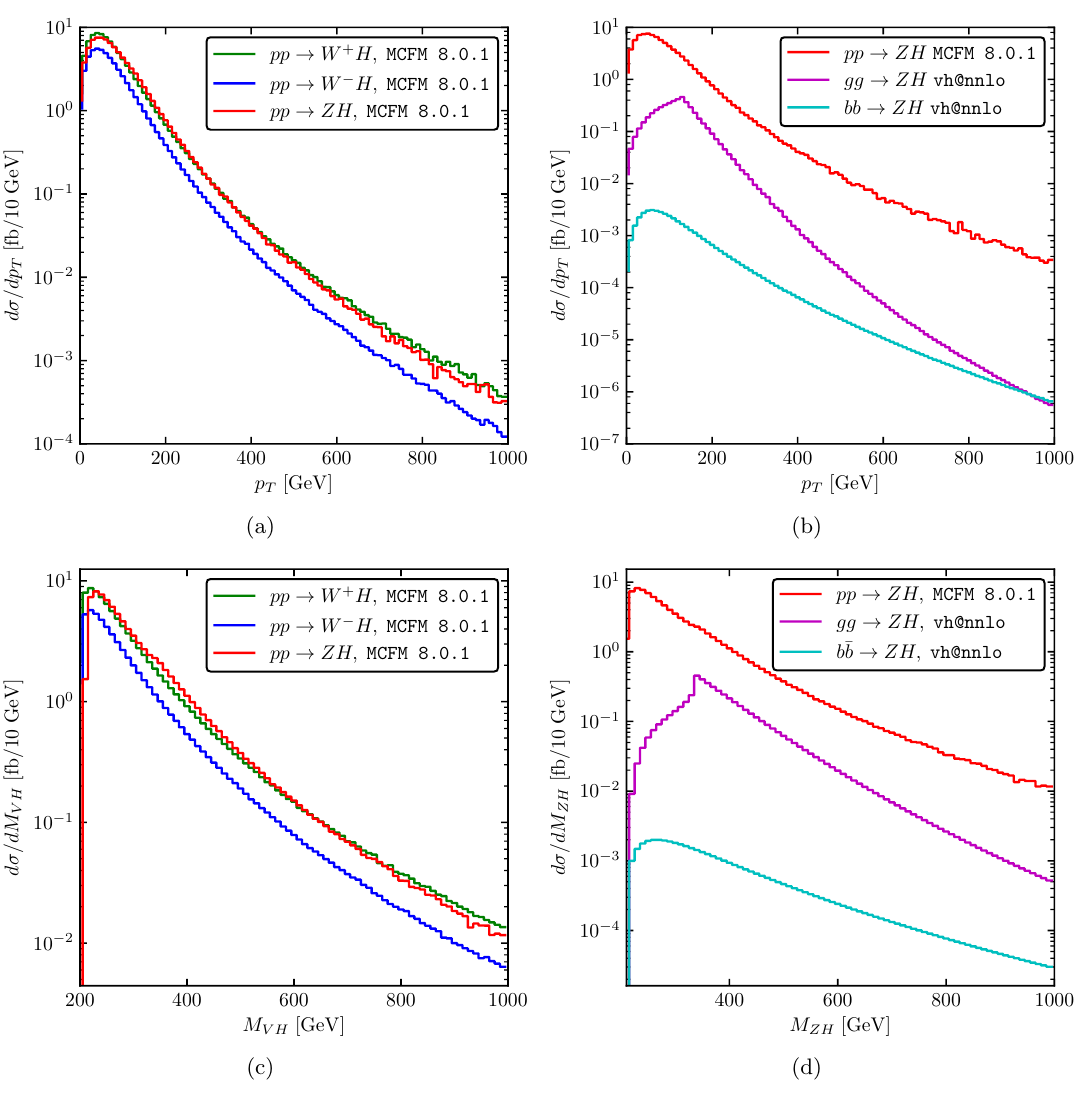
Figure 3 . Example of transverse momentum distributions in (a) and (b) and invariant mass distributions in (c) and (d) for VH production in the SM at the LHC with M H = 125 GeV; (a,c) Comparison of W + H (green), W (cid:0) H (blue) and ZH production (red) created with MCFM 8.0.1 ; (b,d) Comparison of full ZH (red), gluon-induced (magenta) and bottom-induced ZH (cyan) production. All results are obtained at O ( (cid:11) 2 at LO